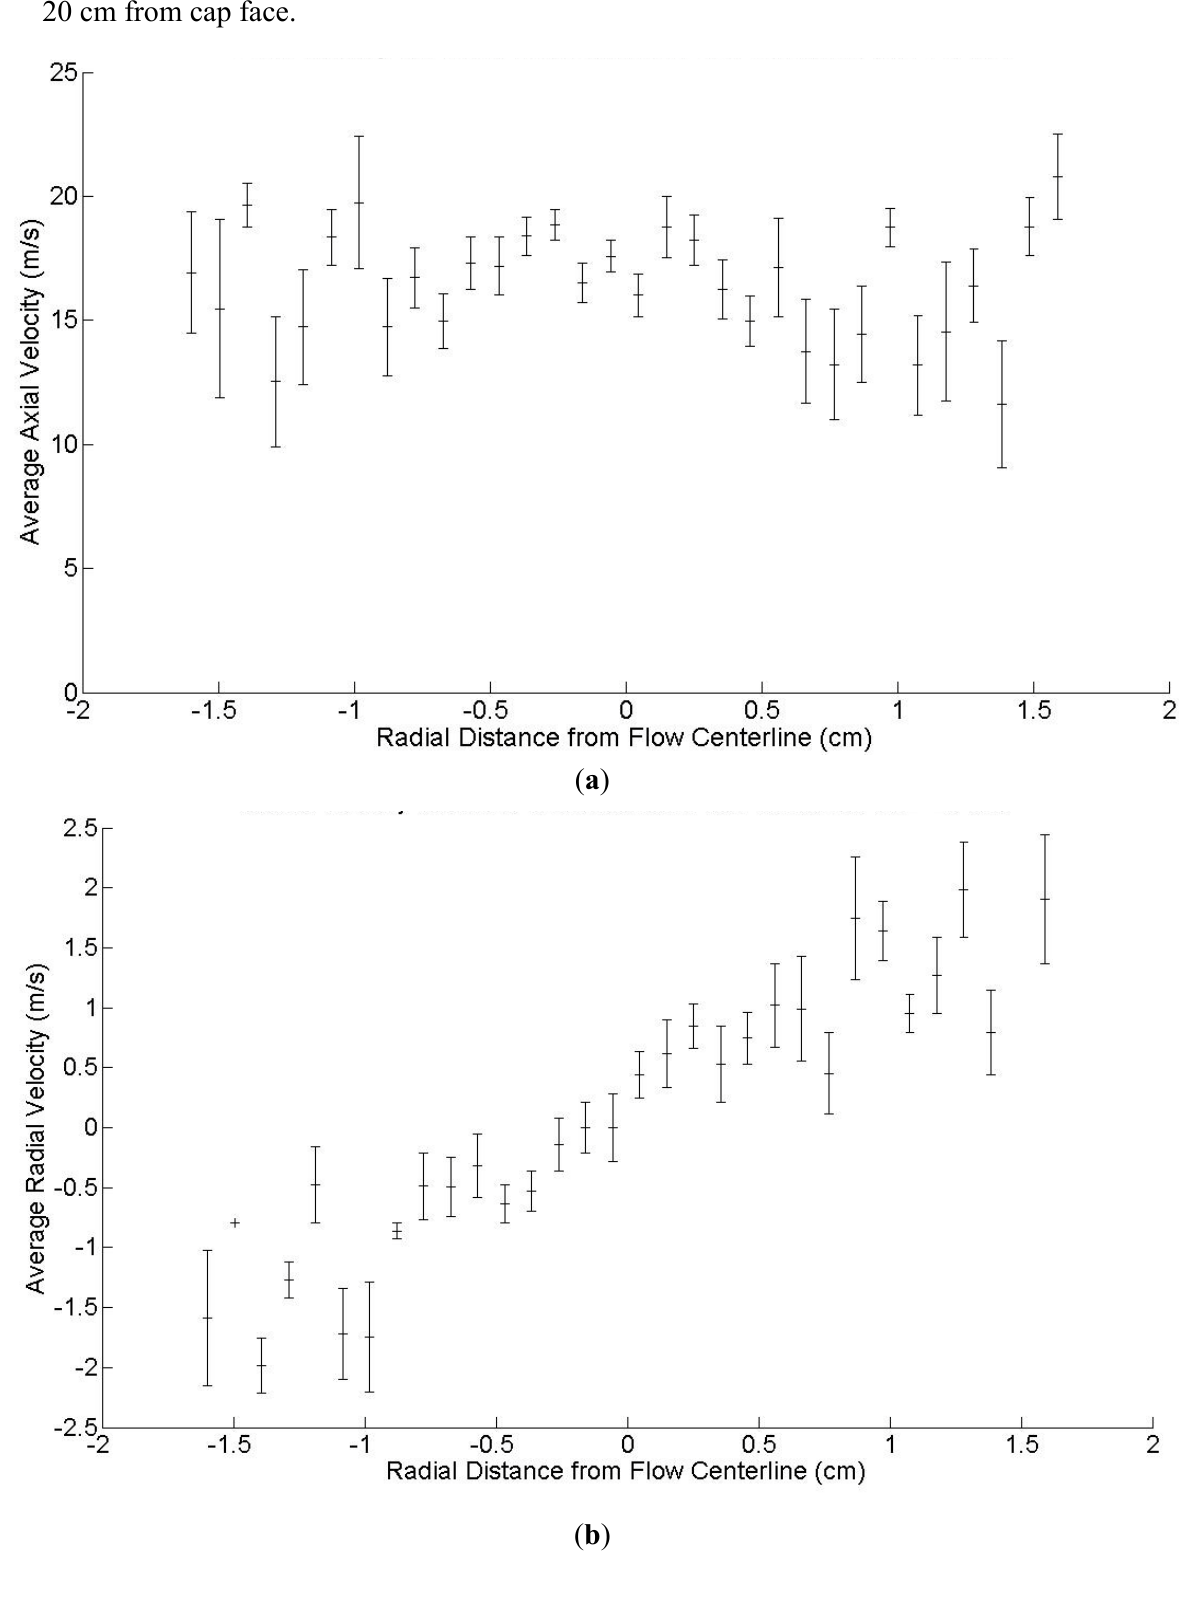
Figure 13. Experiment 3: ( a ) Particle axial velocities and ( b ) particle radial velocities at 20 cm from cap